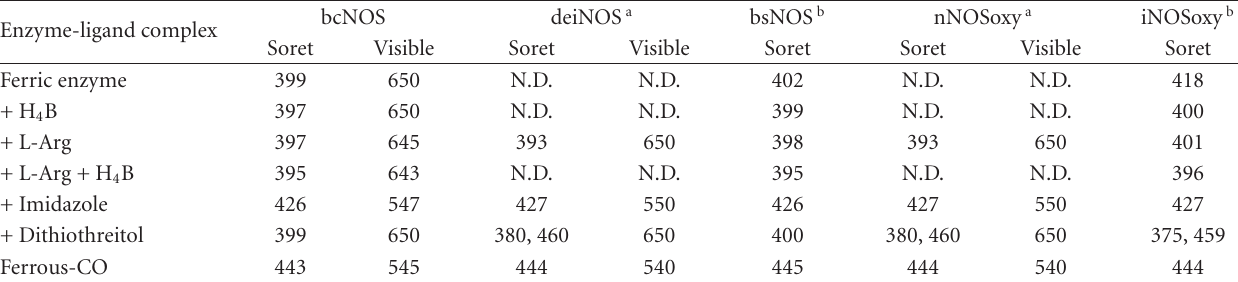
Table 2: Comparison of the binding properties of bcNOS to other bacterial NOS-like and mammalian NOS oxygenase domain proteins. Binding constants ( μ M) bcNOS bsNOS a deiNOS b K d imidazole — K obs L-Arg — — — — — a taken from [8]. b taken from [11]. iNOSoxy: inducible NOS oxygenase domain. nNOSoxy: neuronal NOS oxygenase domain. presence of H 2 O 2 and either NOHA (0.100 ± 0.014 min − 1